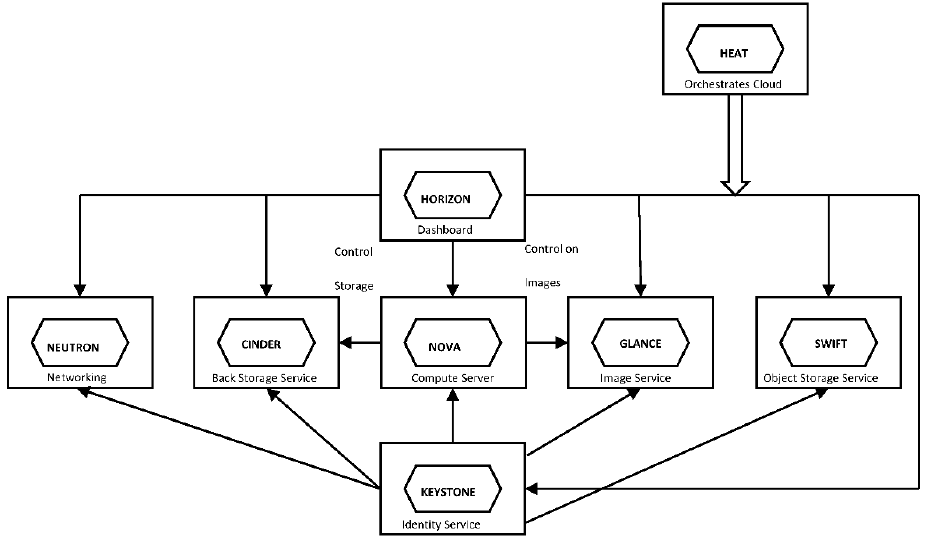
Figure 3. OpenStack system architecture.